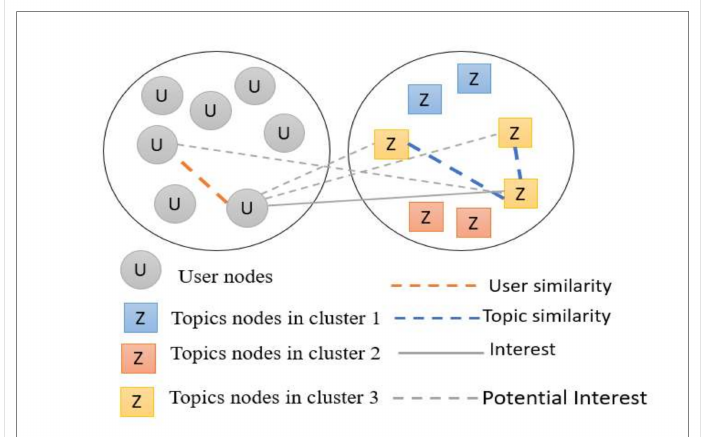
Figure 5. The Proposed Clustering